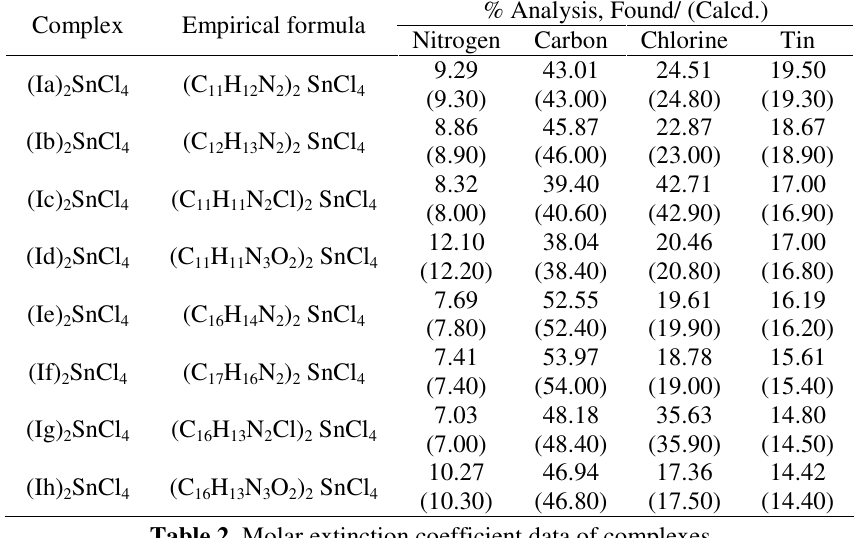
Table 1. Analytical data of complexes % Analysis, Found/ (Calcd.) Complex